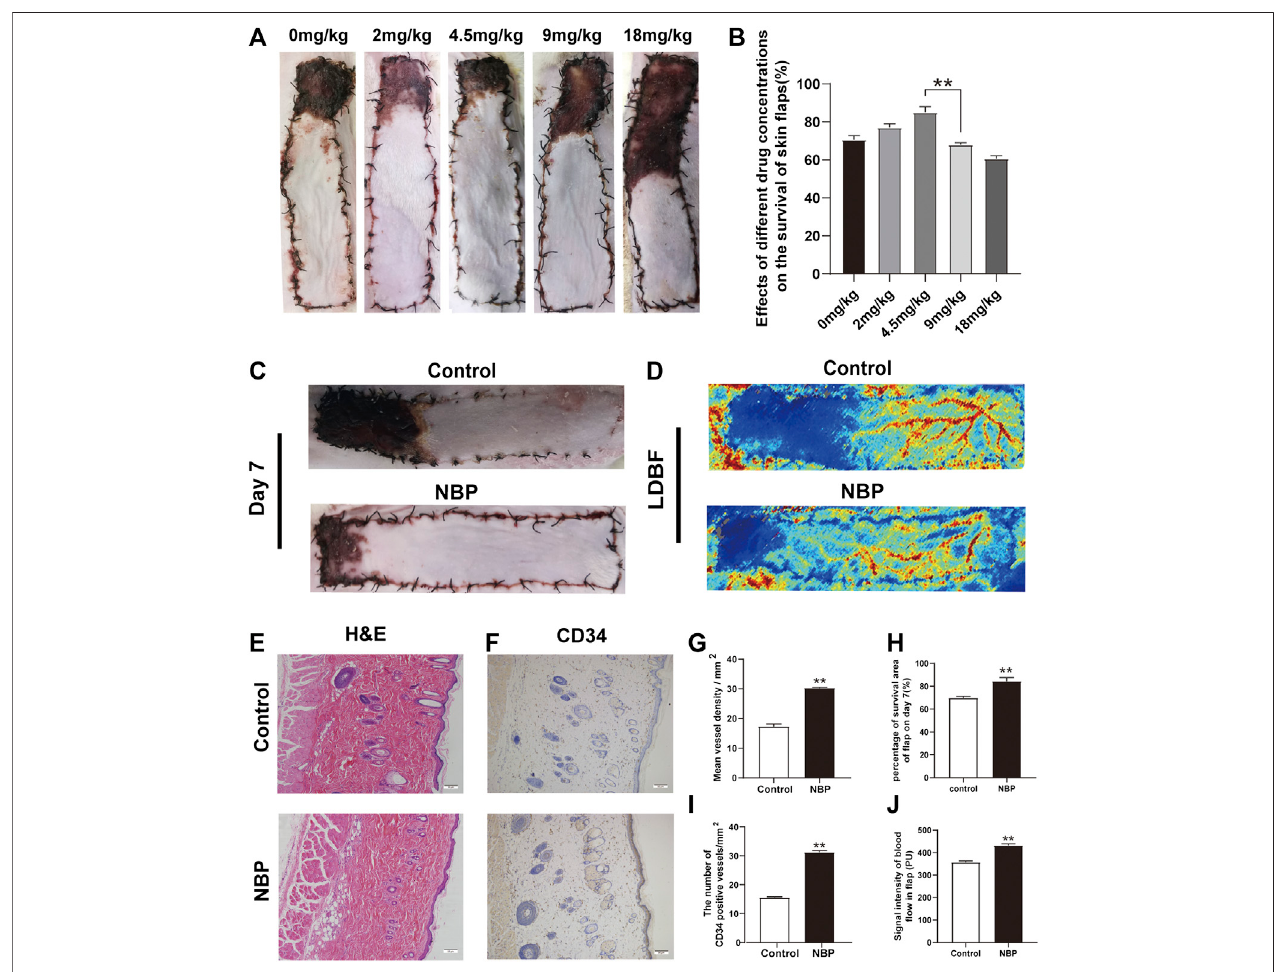
FIGURE 1 | NBP improves survival of multiterritory perforator fl ap. (A) Determine the best dose of the drug by the survival area of rat skin fl ap. (B) Digital images of controlandNBP-treatedratsonPOD7. (C) PercentageofsurvivalareaonPOD7. (D) LDBFineachgrouponPOD7. (E) Percentageofblood fl owsignalintensitywithin the fl ap. (F) H&EstainingofbloodvesseldensityinthecontrolandNBPgroups(200X);scalebar,50 μ m. (G) IHCstainingforCD34inthechoke Ⅱ zoneofthecontroland NBPgroups (200X); scalebar,50 μ m. (H) Percentageofmicrovasculardensity (MVD) ineach group. (I) Percentage ofCD34positivevessels.Values areshown as mean ± SEM, n (cid:1) 6 per group. * p < 0.05 and ** p < 0.01 vs. control group.